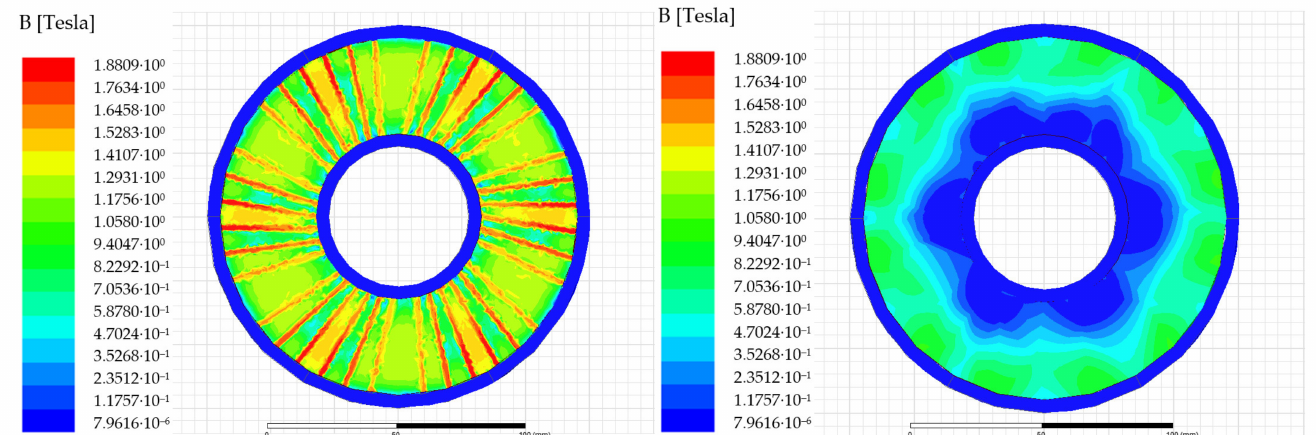
Figure 9. The distribution of the magnetic flux density in the symmetrical half of the inner rotor from the side of air gap δ 2 ( left ); the distribution of the magnetic flux density in the plane of the inner rotor symmetry ( right